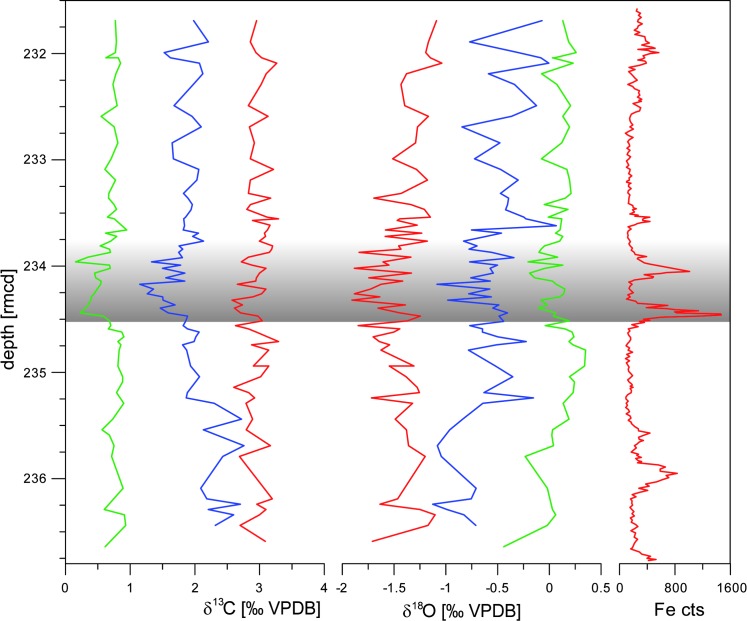
A) and B) δ13C and δ18O of benthic (green), planktic subsurface (blue) and surface (red) foraminifera in comparison to C) XRF measured Fe counts for chemostratigraphic correlation.The LDE is marked in grey, stable isotope data can be found in S2 Table.